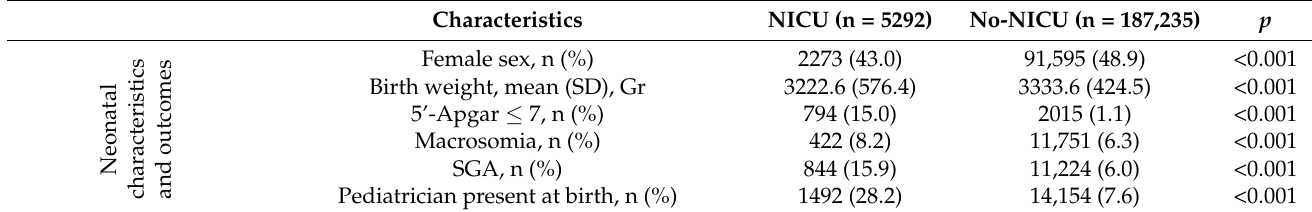
Table 1. Cont. Characteristics